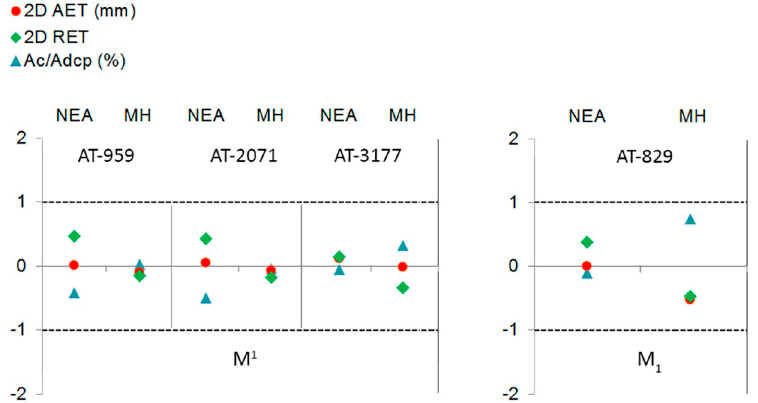
Fig 3. Adjusted Z score of the 2D variables (AET, RET and percentage of dentine). Assessed in the maxillary (specimens AT-959, AT-2071, AT-3177) and mandibular (specimen AT-829) molars from SH and compared to the variation expressed by Neanderthals (blue triangles) and modern humans (red circles). The solid line passing through zero represents the mean, and the other two lines correspond to the estimated 95% limit of variation expressed for the two comparative